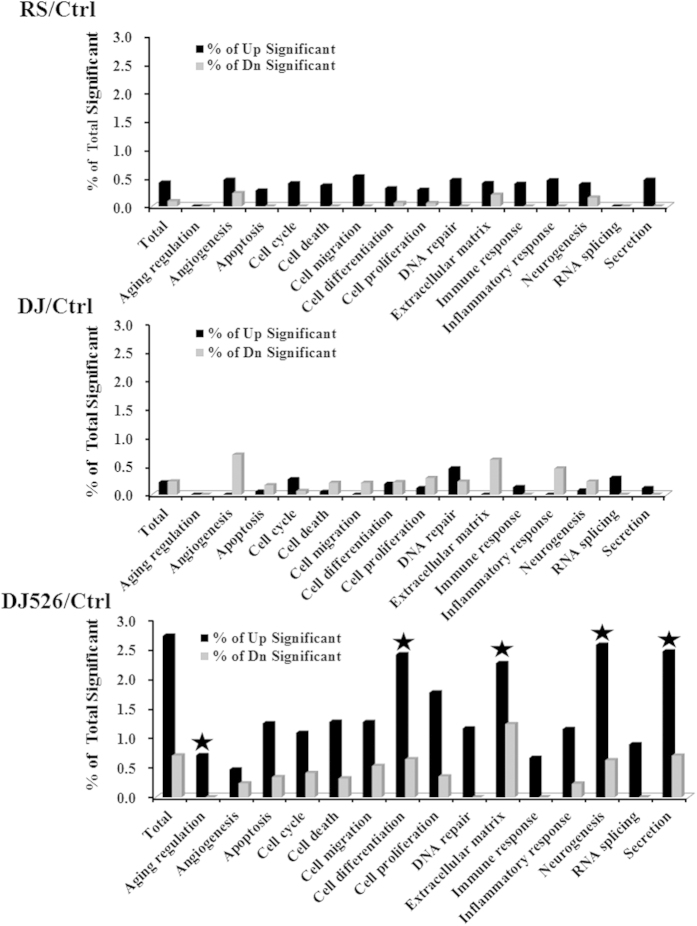
The gene ontology analyses of the microarray data from the mice on resveratrol (RS), Dongjin rice (DJ), resveratrol-enriched rice DJ526 (DJ526), or control (Ctrl) diet.The control (Ctrl) mice fed a NFD in which the carbohydrate source was corn starch and sucrose; The resveratrol (RS) mice fed a NFD in which the carbohydrate source was corn starch and sucrose except containing resveratrol; Dongjin (DJ) mice fed a NFD in which the corn starch and sucrose were replaced with Dongjin rice; DJ526, mice fed a NFD in which the corn starch and sucrose were replaced with the resveratrol enriched rice DJ526. The resveratrol concentration in DJ526 and RS groups was 0.69 μg/g each, and not detected in Ctrl and DJ groups. Each panel represents the gene ontology data which were analyzed from the microarray data at the end of 6 month feeding experiments. The gene ontology analyses were performed from the microarray data filtered using cutoff a fold-change of >1.5 and p value of <0.05. The most significantly altered gene expression patterns by DJ526 treatment are indicated in symbol (★).